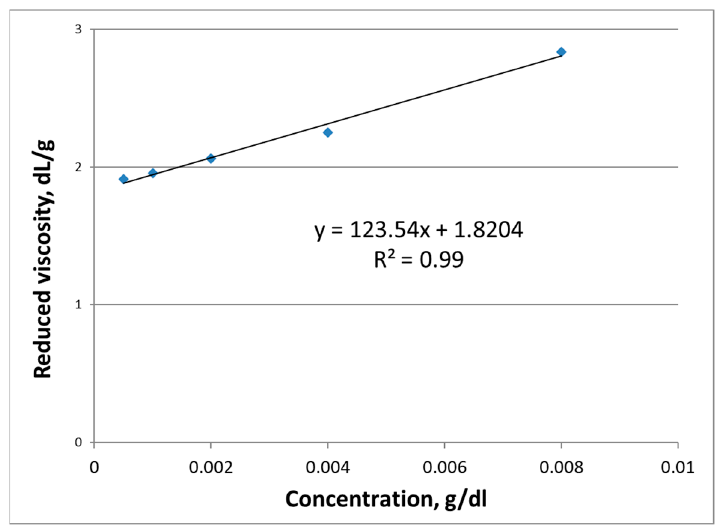
Figure A1. Reduced viscosity of the PAAm aqueous solutions as function of concentration. By substituting the obtained value for the intrinsic viscosity (1.8204 dL/g) in Mark- Houwink equation (Equation (A1)), the obtained average molecular weight of the synthe- sized PAAm is 3.76 × 10 5 Da.